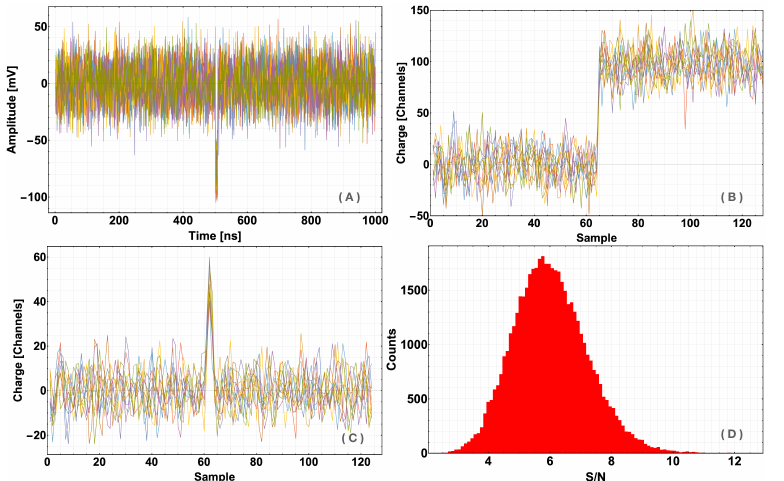
Figure 12. ( A ) A set of PMT-simulated waveforms corresponding to a 20 keV release of energy in the detector. ( B ) The corresponding charge integrated signals obtained from the set of PMT simulated waveforms. ( C ) The matched filter output. ( D ) Histogram of S/N